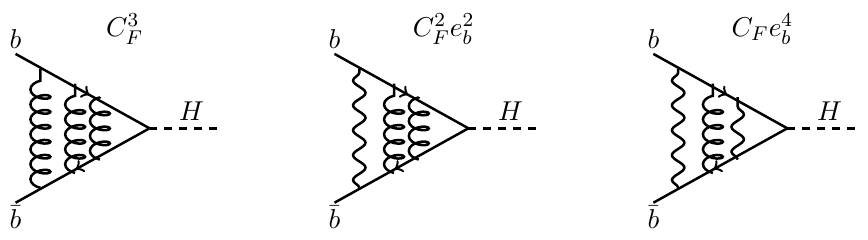
Figure 1 . An example of Feynman diagram which contributes to the color factors C 3